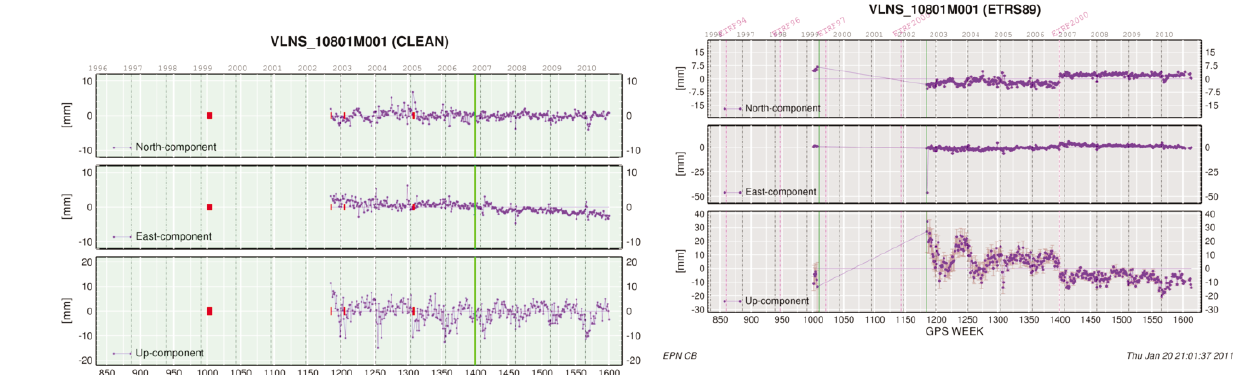
Fig. 9. The evolution of VLNS ETRF geocentric coordinates considering three components: north-south, east-west and up (EUREF… 2011)